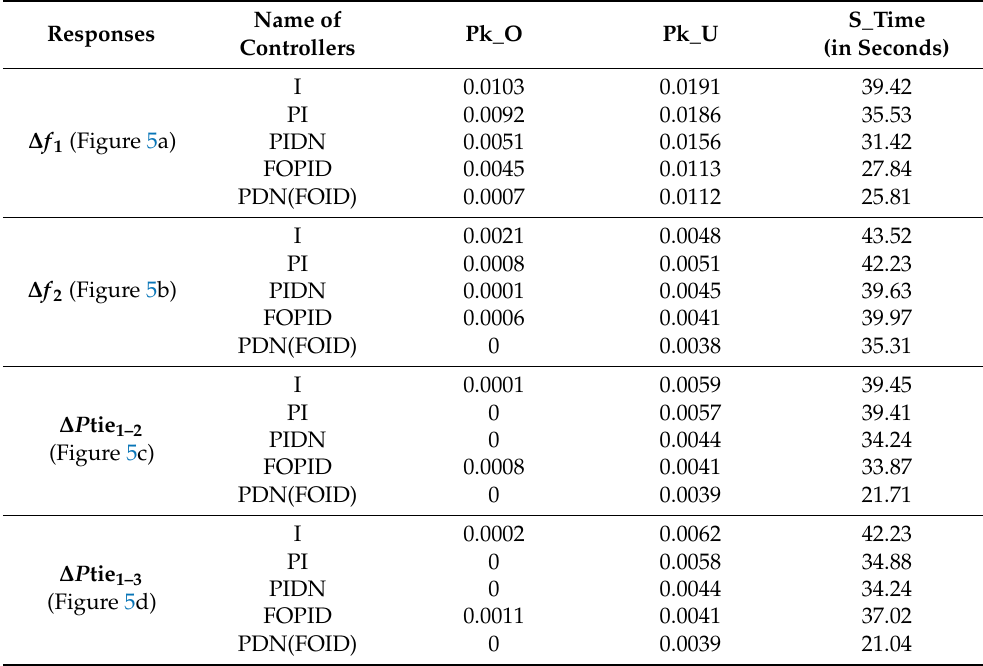
Table 2. Peak anomaly and duration of settling for outcomes in Figure 5 in the case of system-1 employing SHO-optimized I/PI/PIDN/FOPID/PDN(FOID) controllers.